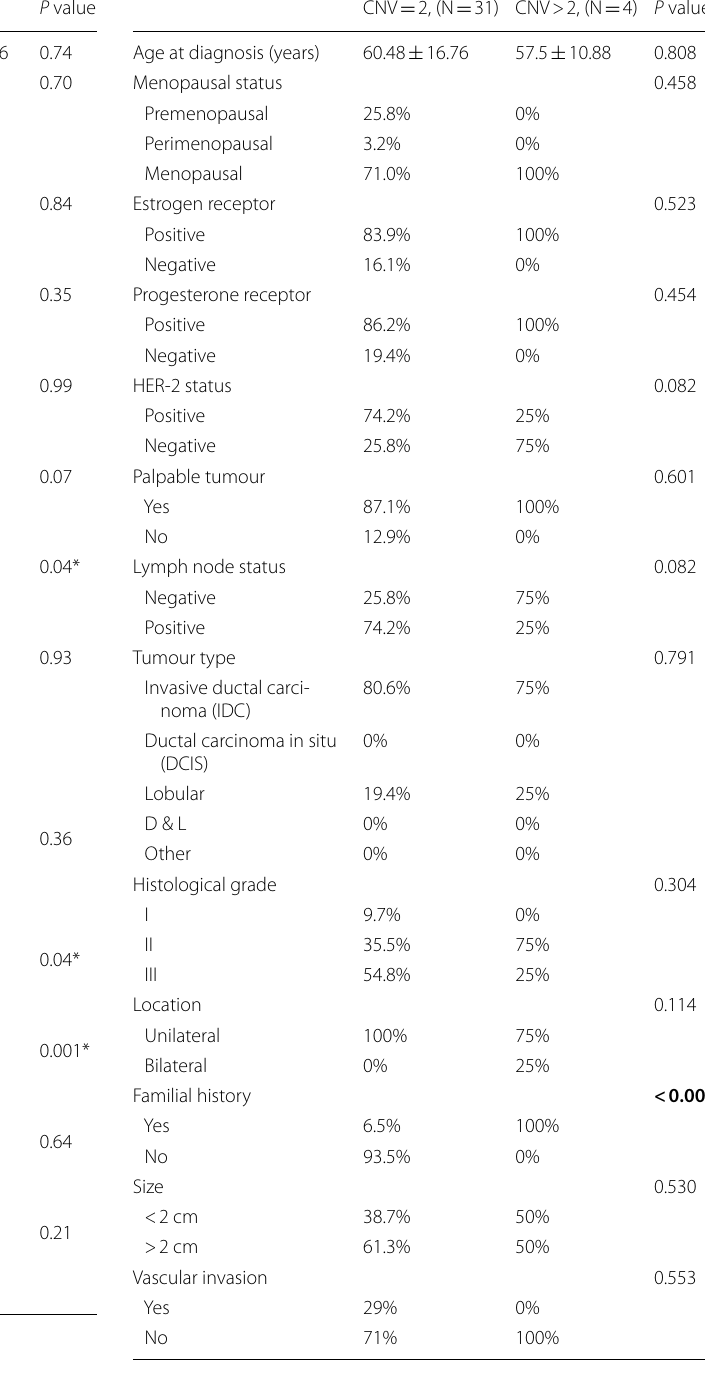
Table 2 Pathological characteristics in two group of patients. Data are presented as proportion of individuals within each category